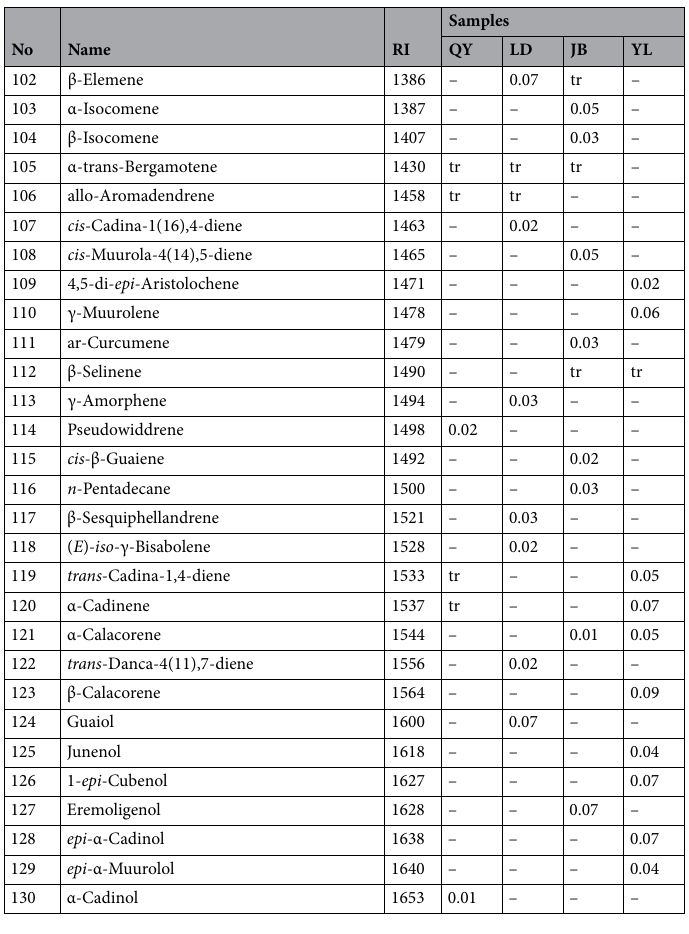
Table 2. Chemical constituents of the thyme oil in the four regions. a: “–” means the compound is not identified; b: “tr” represent the percent of compound is lower than 0.05%; c:“RI” represent the Retention indices on the DB-5